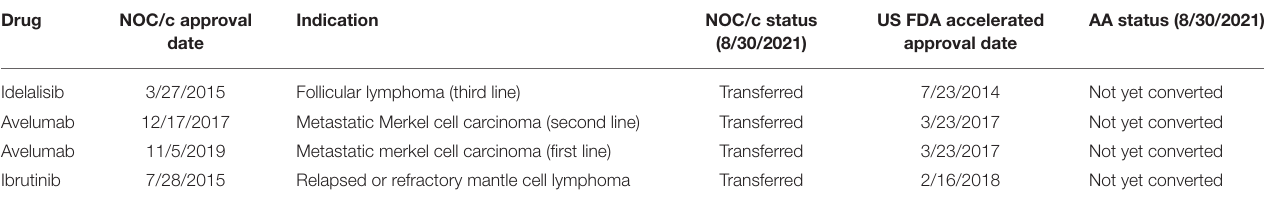
TABLE 3 | NOC/c and AA Approvals, conditions removed in Canada and not US.